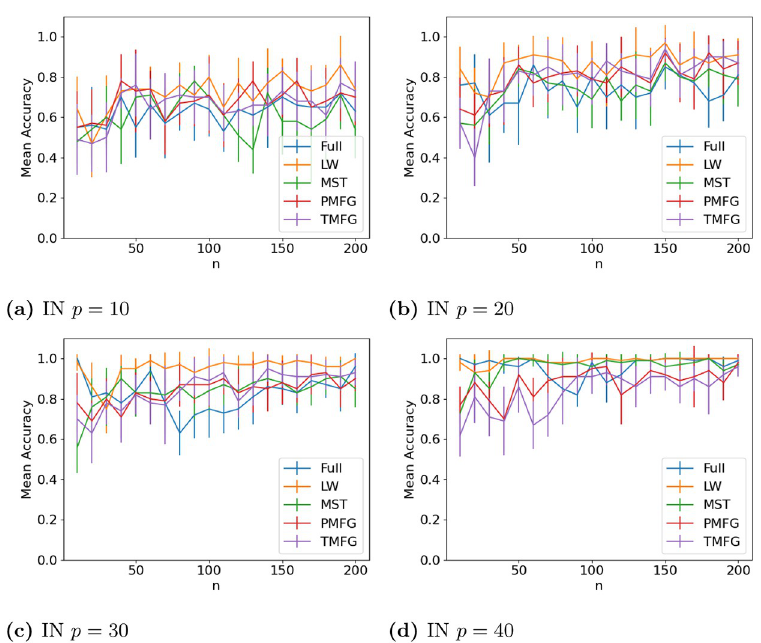
Fig 13. Accuracy when distinguishing between correlation matrices created from the stock windows with the maximum and minimum volatility using the SF method and a random forest classifier for India. (a) IN p = 10, (b) IN p = 20, (c) IN p = 30, (d) IN p =